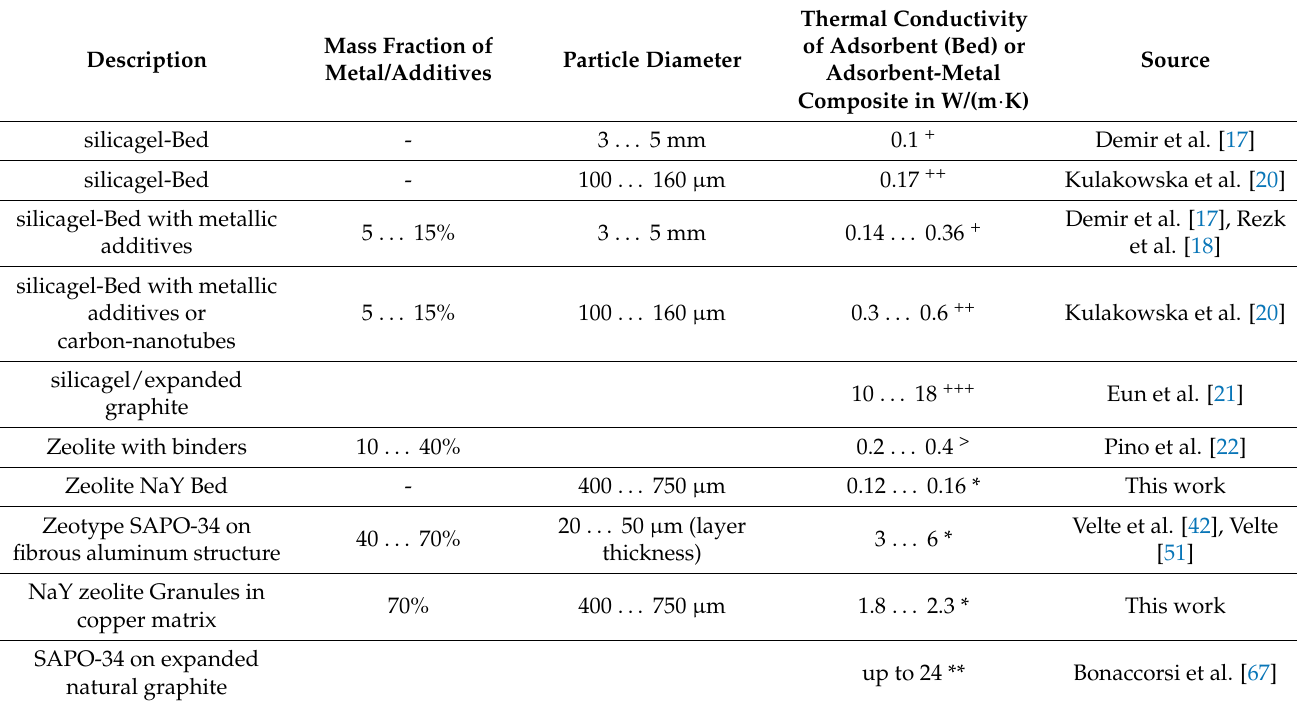
Table 9. Thermal conductivity of adsorbent beds, adsorbent–metal mixtures, and adsorbent–metal